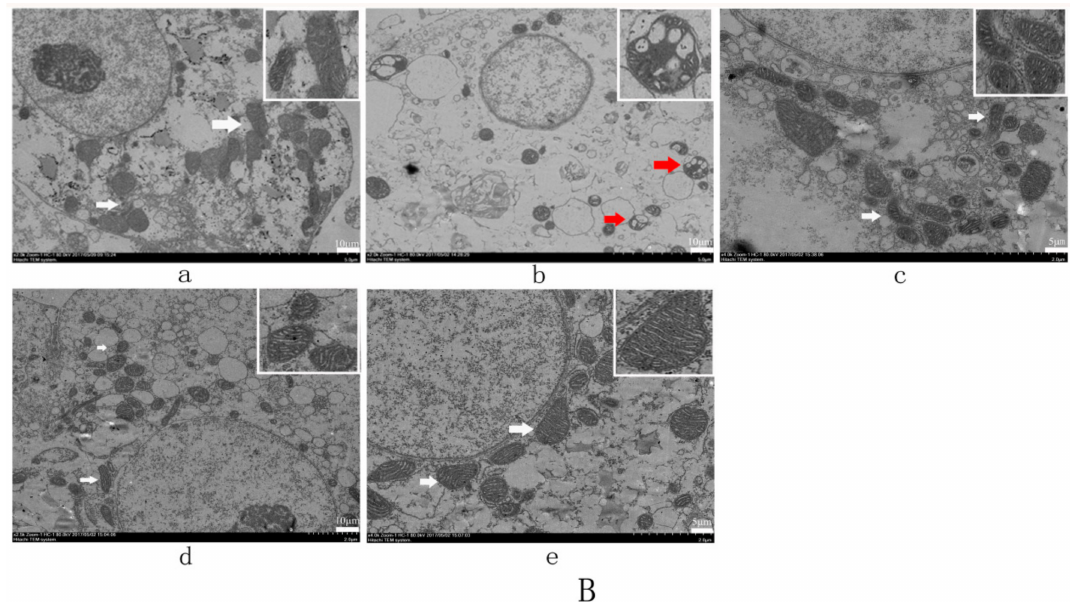
Figure 3. ( A ) the mitochondrial membrane potential change in chicken hepatocytes (scale bar = 100 µ m). ( B ) the structural features of chicken primary hepatocytes ( a ) the control group (scale bar = 10 µ m); ( b ) the model group (scale bar = 10 µ m); ( c ) the 0.01 µ g/mL CAG group (scale bar = 5 µ m); ( d ) the 0.1 µ g/mL CAG group (scale bar = 10 µ m); ( e ) the 1 µ g/mL CAG group (scale bar = 5 µ m). The white arrow means the normal mitochondrial ridge and the red arrow means the swelling, vacuolization and degeneration of the